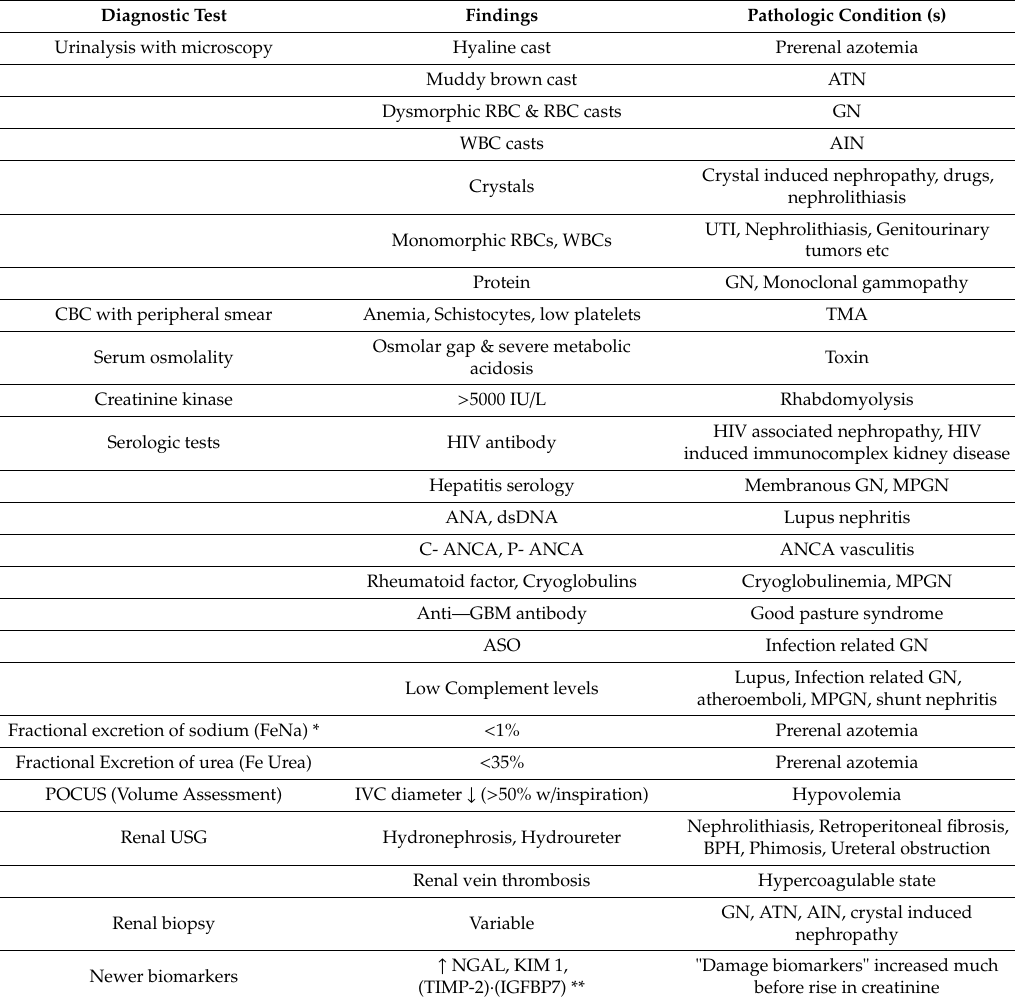
Table 3. Diagnostic tests in patients with AKI